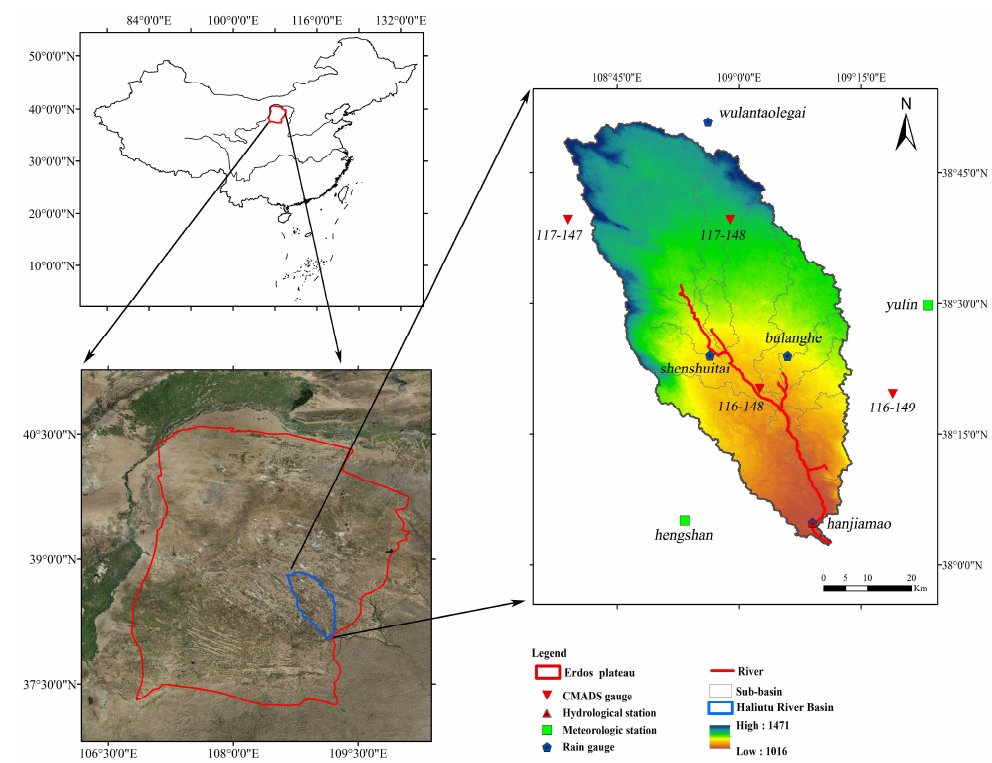
Figure 1. The location of the Hailiutu River basin and its digital elevation model with hydrometeorological stations.